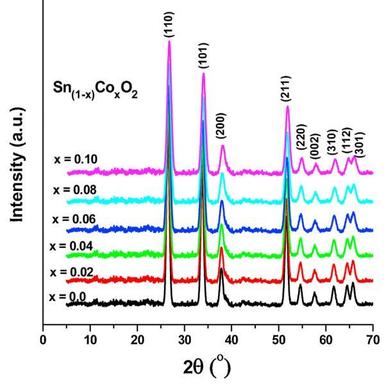
X-ray diffraction pattern of Sn1−xCoxO2 (with 0 ≤ x ≤ 0.10) nanoparticles.